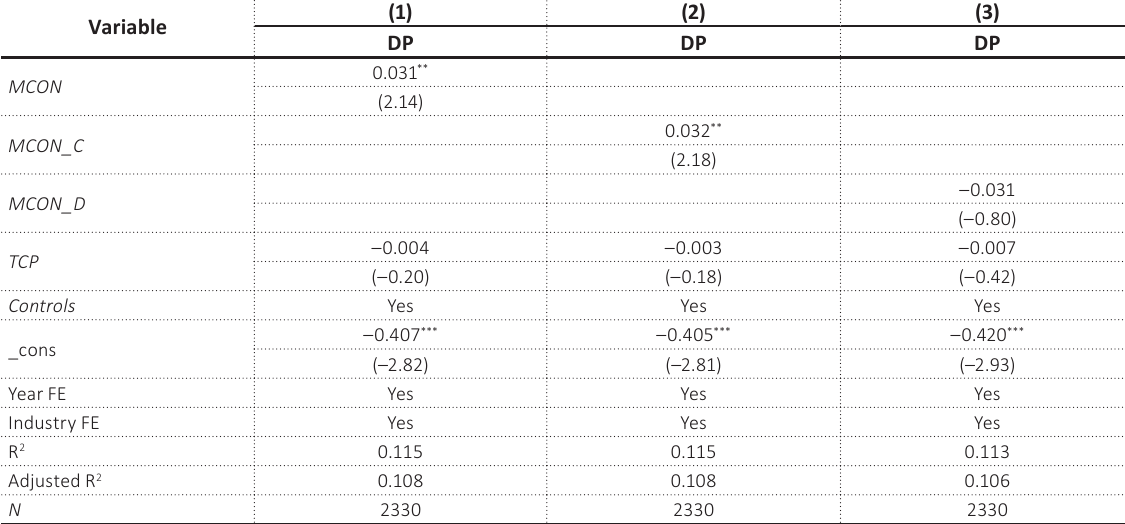
Table 5. Military-connected firms and debt policy